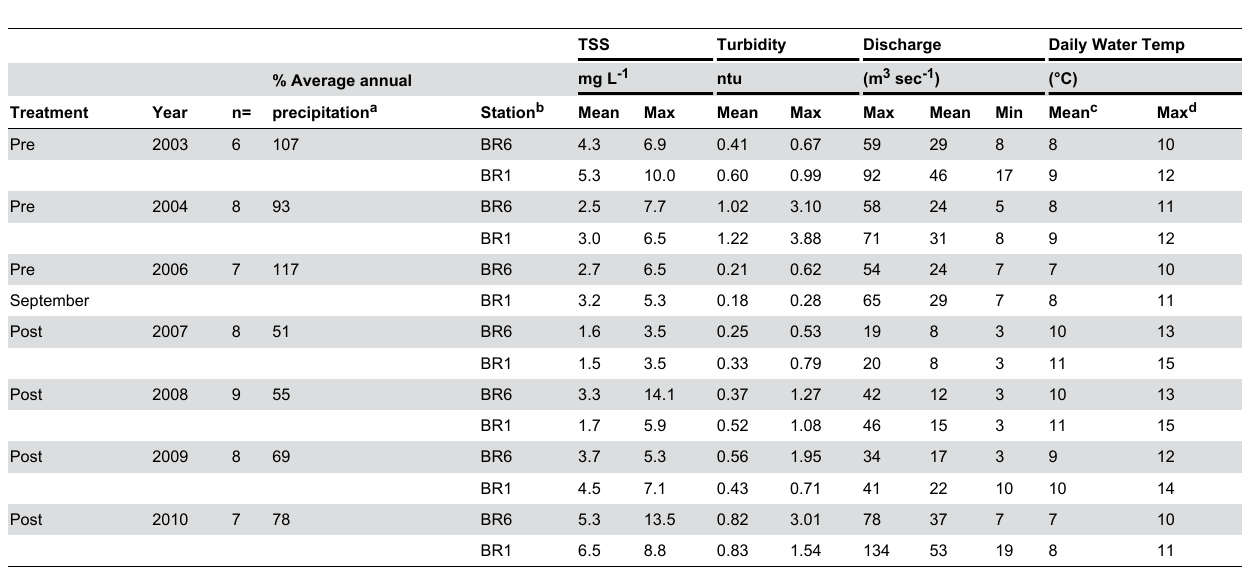
Table 6. Mean and maximum annual values of total suspended solids (TSS), turbidity, discharge and stream temperature measured at Bailey